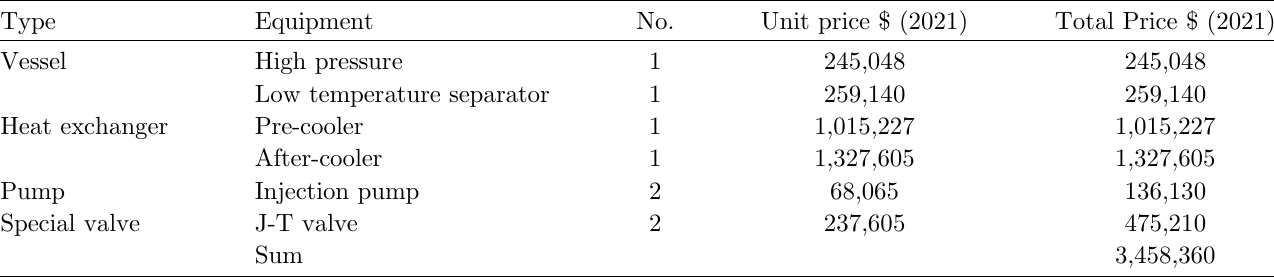
Table 5. Process equipment ( fi xed) costs for each dew point control unit